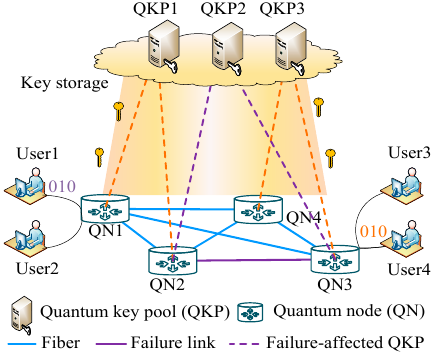
Figure 7. The QKD network architecture with QKP.